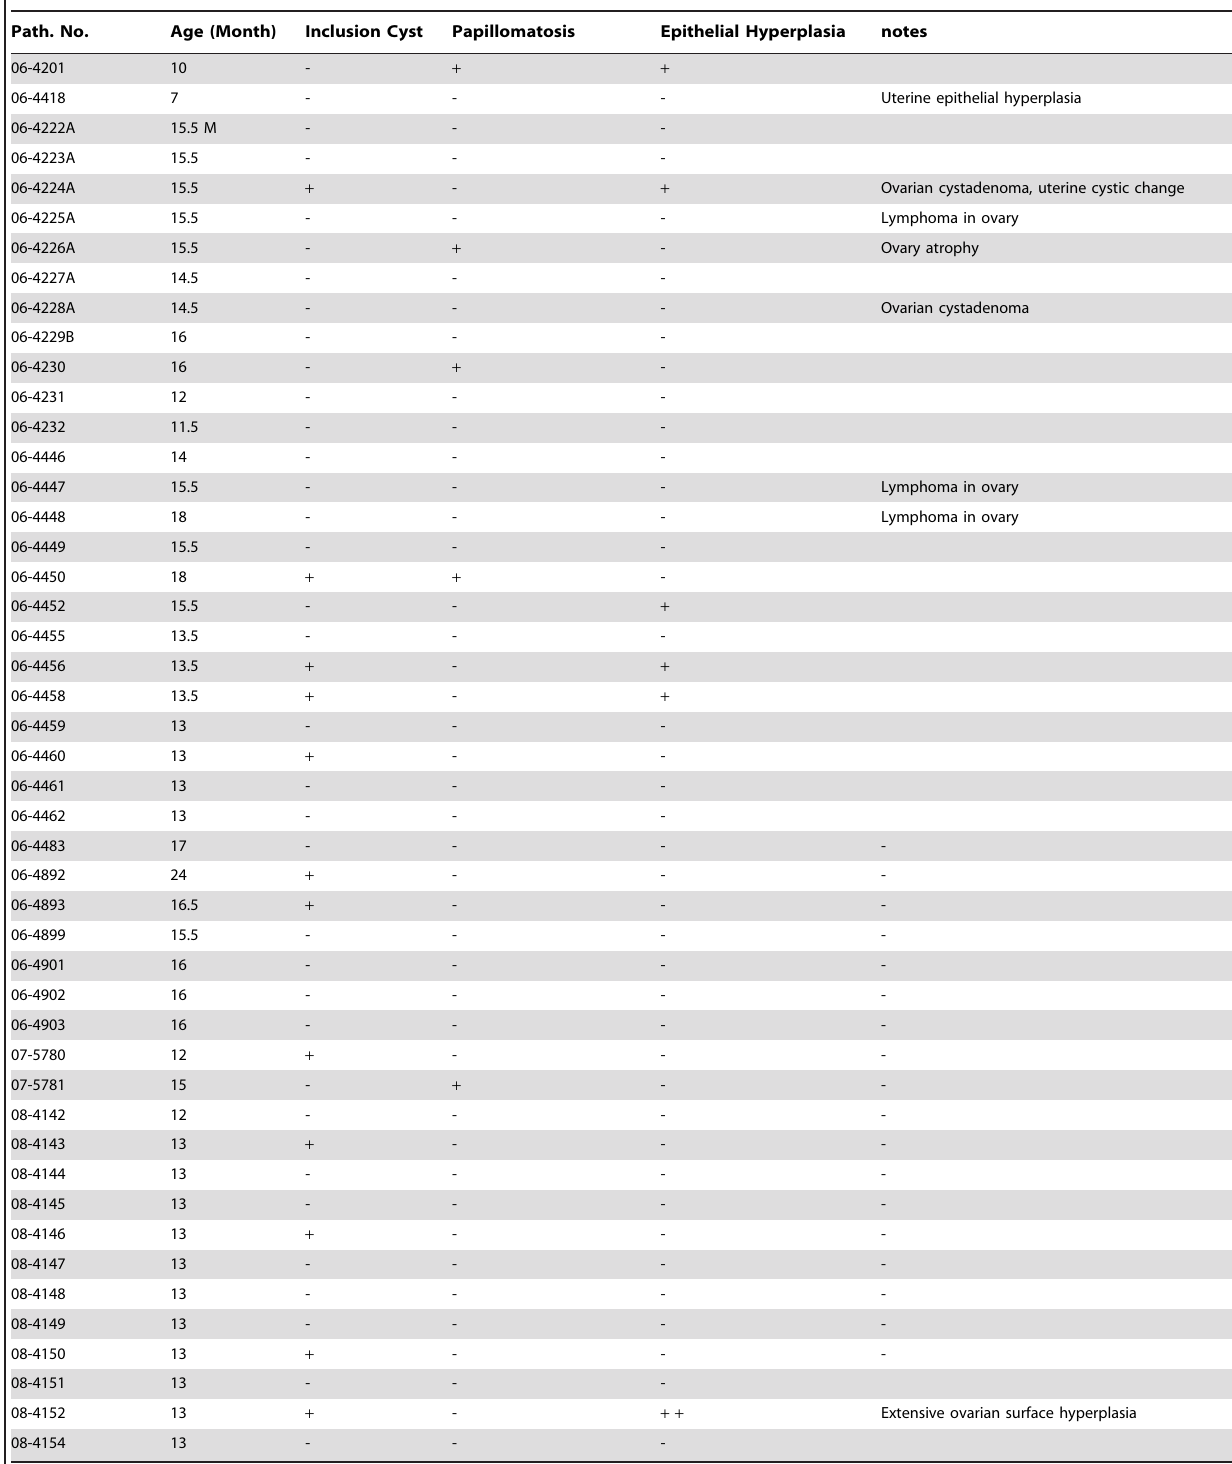
Table 2. Pathology report in GATA6 Heterozygous mouse ovaries.